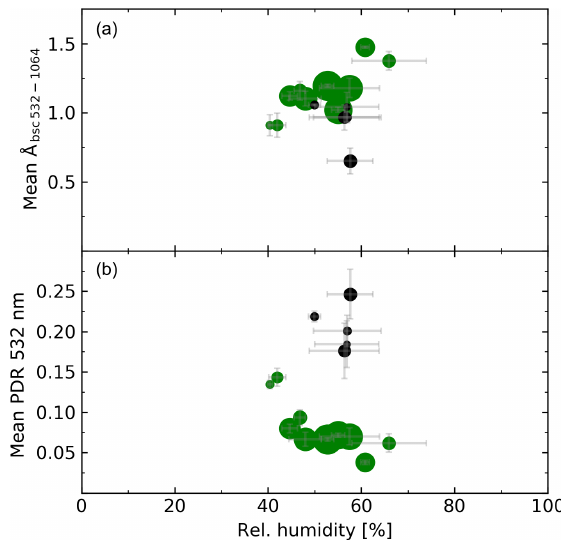
Figure 6. Dependence of the backscatter-related Ångström expo- nent at 532–1064nm (a) and the particle depolarization ratio at 532nm (b) on the relative humidity for all Raman measurements of pure and mixed birch cases during the first period (5–10 May, green) and the second period (12–15 May,